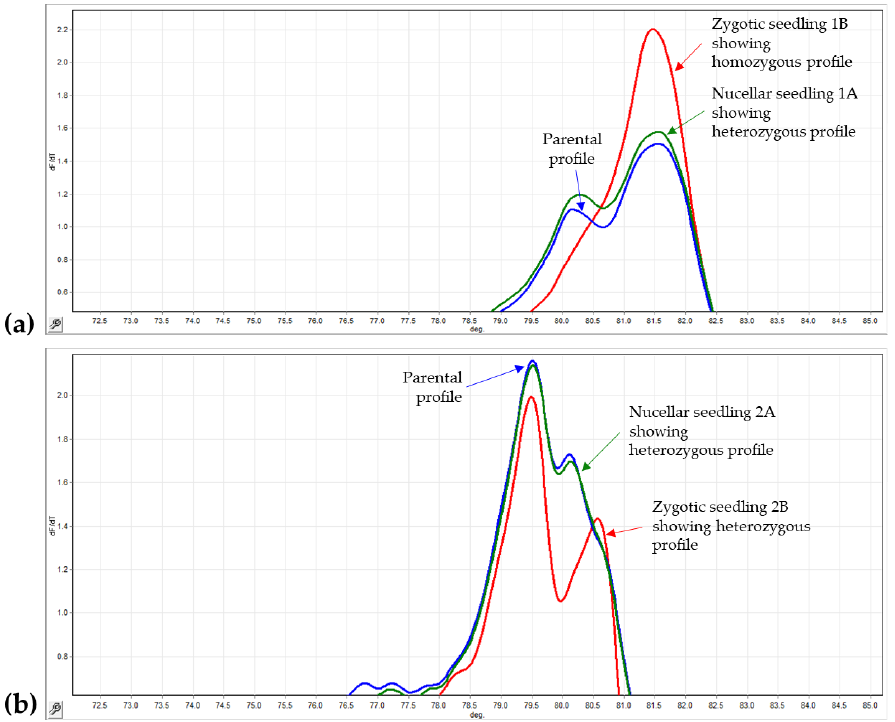
Figure 2. ( a ) Marker SNP U455 on parental DNA of lemon ‘Lisbon’ and two seedlings grown from the same seed (1A and 1B); ( b ) marker SSR INRA 338 on parental DNA of ‘Femminello Siracusano m296’ and two seedlings grown from the same seed (2A and 2B).